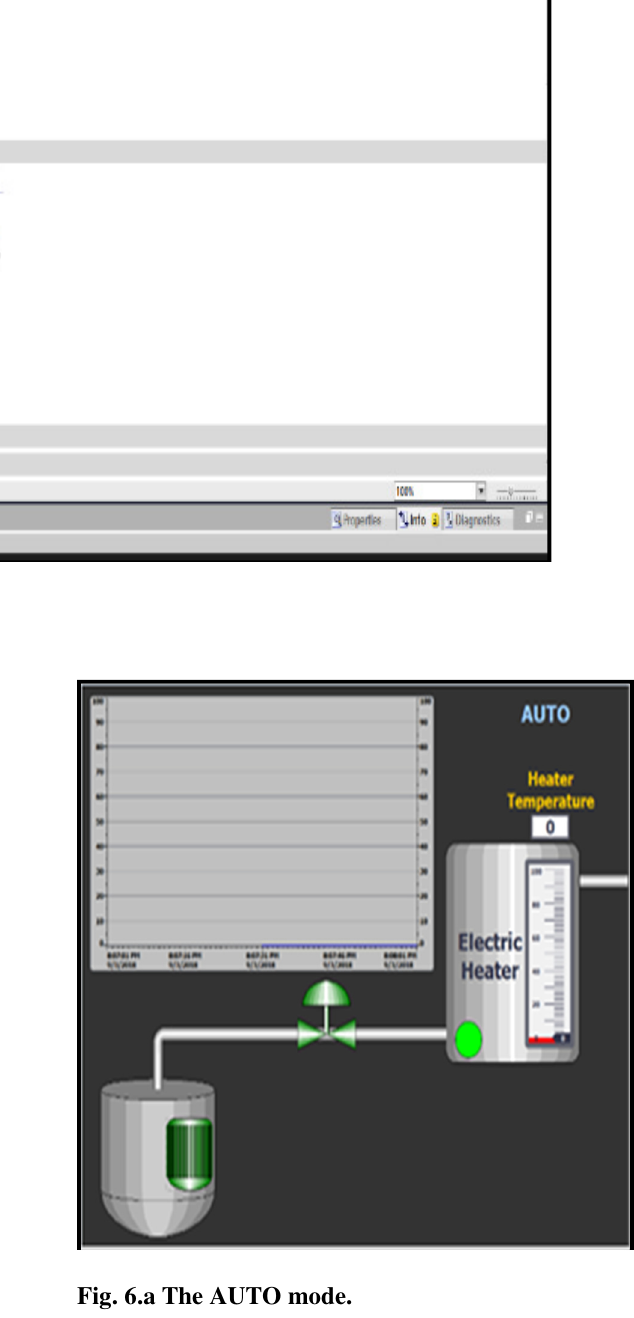
Fig. 6.a The AUTO